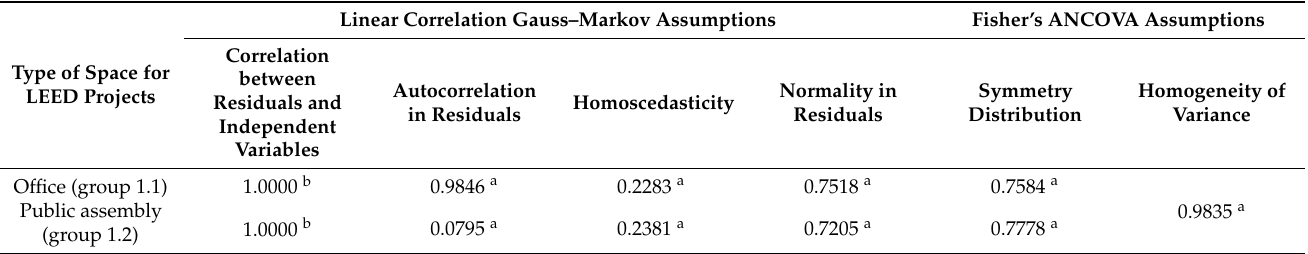
Table A1. Case 1: p -values of Gauss–Markov and Fisher’s ANCOVA assumptions where Y-variable is EAc7 achievement credit and X-covariate is project size from same LEED-NC v4 certified projects.